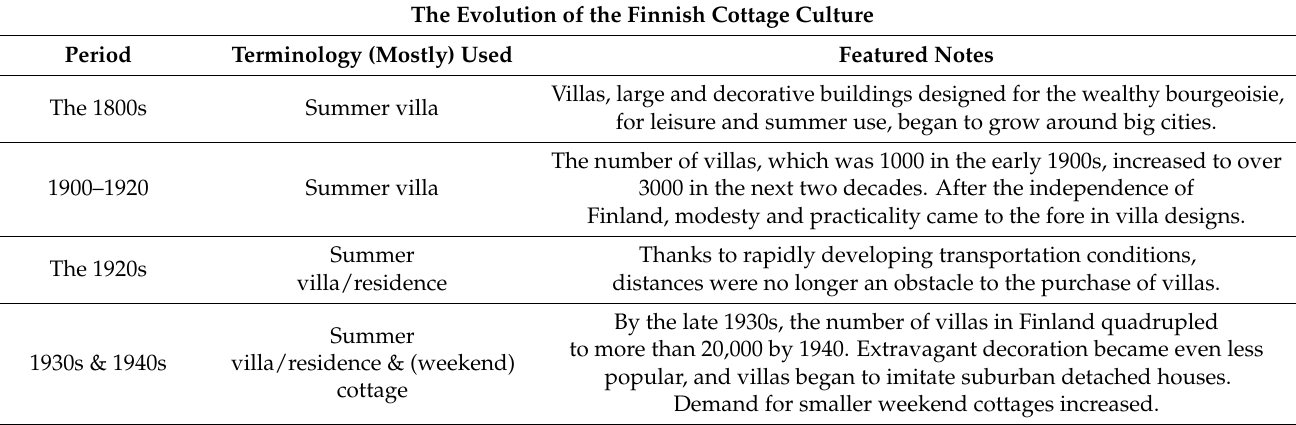
Table 1. The evolution of Finnish cottage